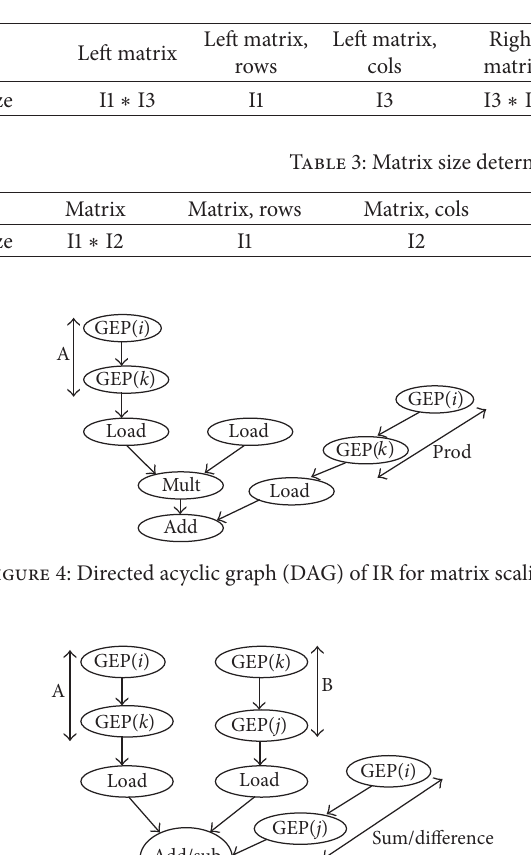
Table 2: Matrix size determination for matrix-matrix multiplication.